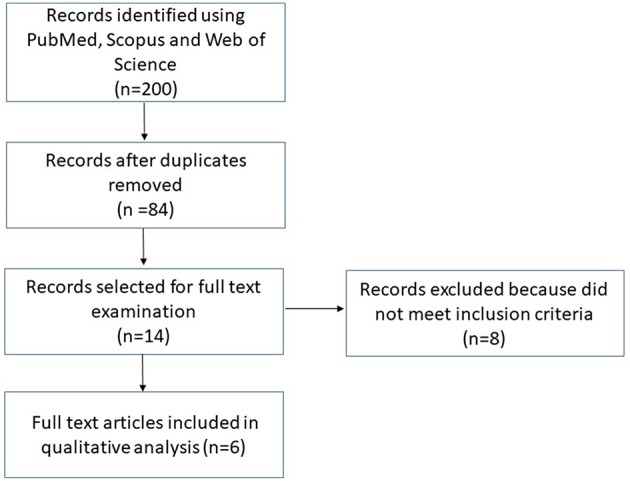
Flow-chart summarizing the selection process.